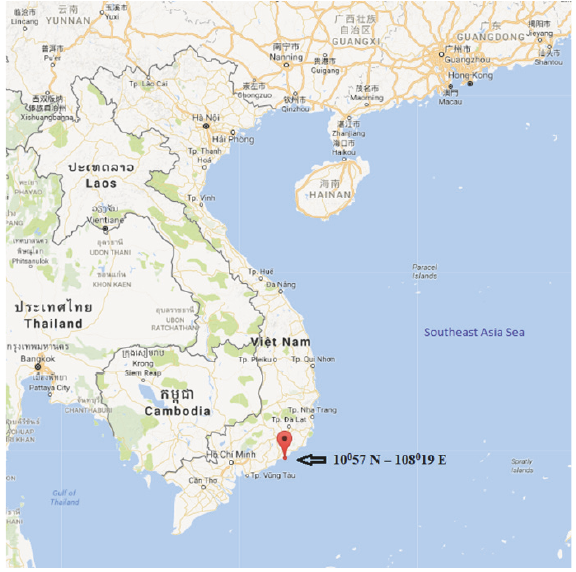
Figure 1: Hon Rom Beach, Phan Thiet City, Binh Thuan Province, Vietnam, where the seawater samples are